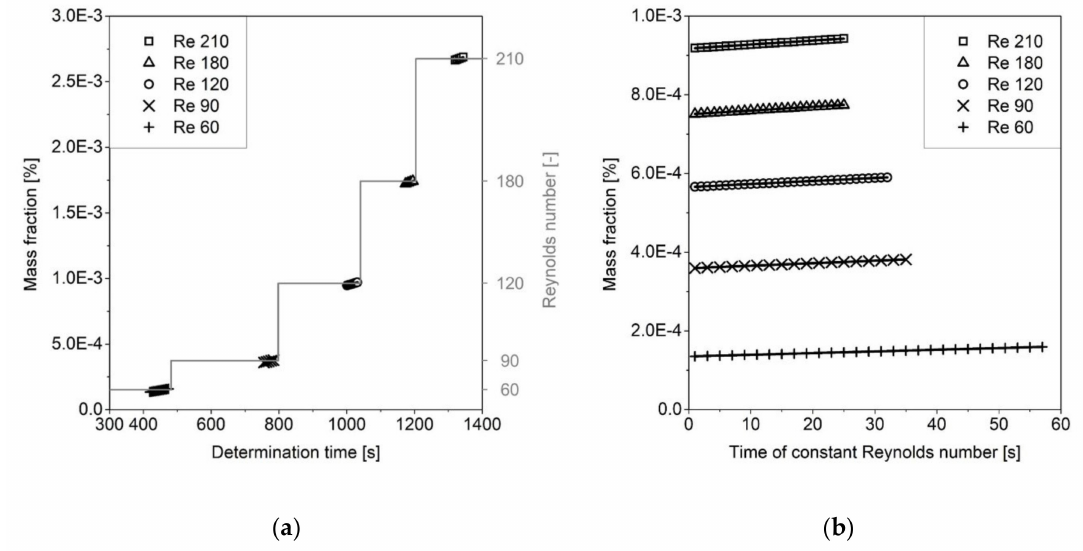
Figure 4. Theophylline dissolution kinetics at different Reynolds numbers ( a ) and regressions of the release rates ( b